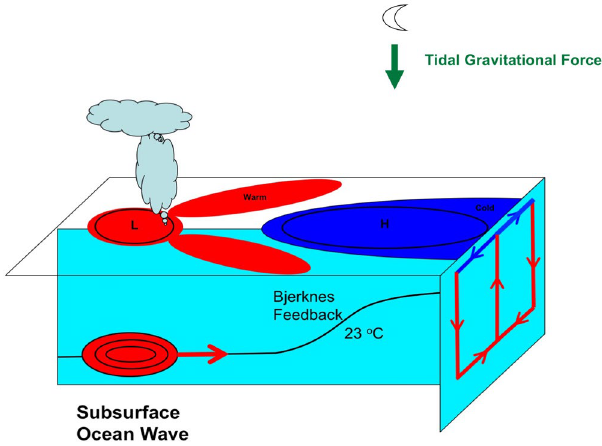
Figure 4. Schematic depiction of the physical mechanisms leading to the switch between El Nino and La